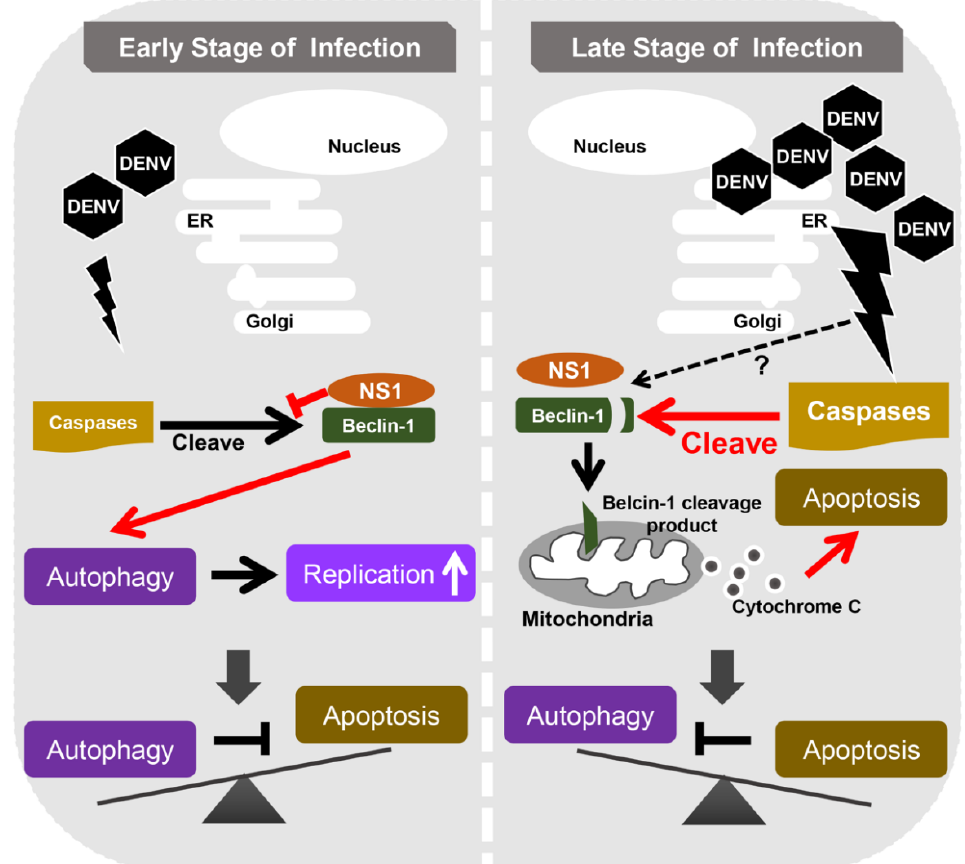
Figure 6. The proposed schematic model of Beclin-1 stability in regulating autophagy and apoptosis during DENV replication. DENV infection activates both autophagy and apoptosis. In the early stage of infection, DENV NS1 interacts with Beclin-1 to interfere with caspase-mediated Beclin-1 cleavage and hence facilitates autophagy to inhibit early apoptotic cell death, and therefore helps DENV replication. However, in the late stage of infection (after 48 h post infection), higher levels of activated caspases cleave Beclin-1 into fragments. This may lead to autophagy attenuation and cause severe apoptotic cell death.